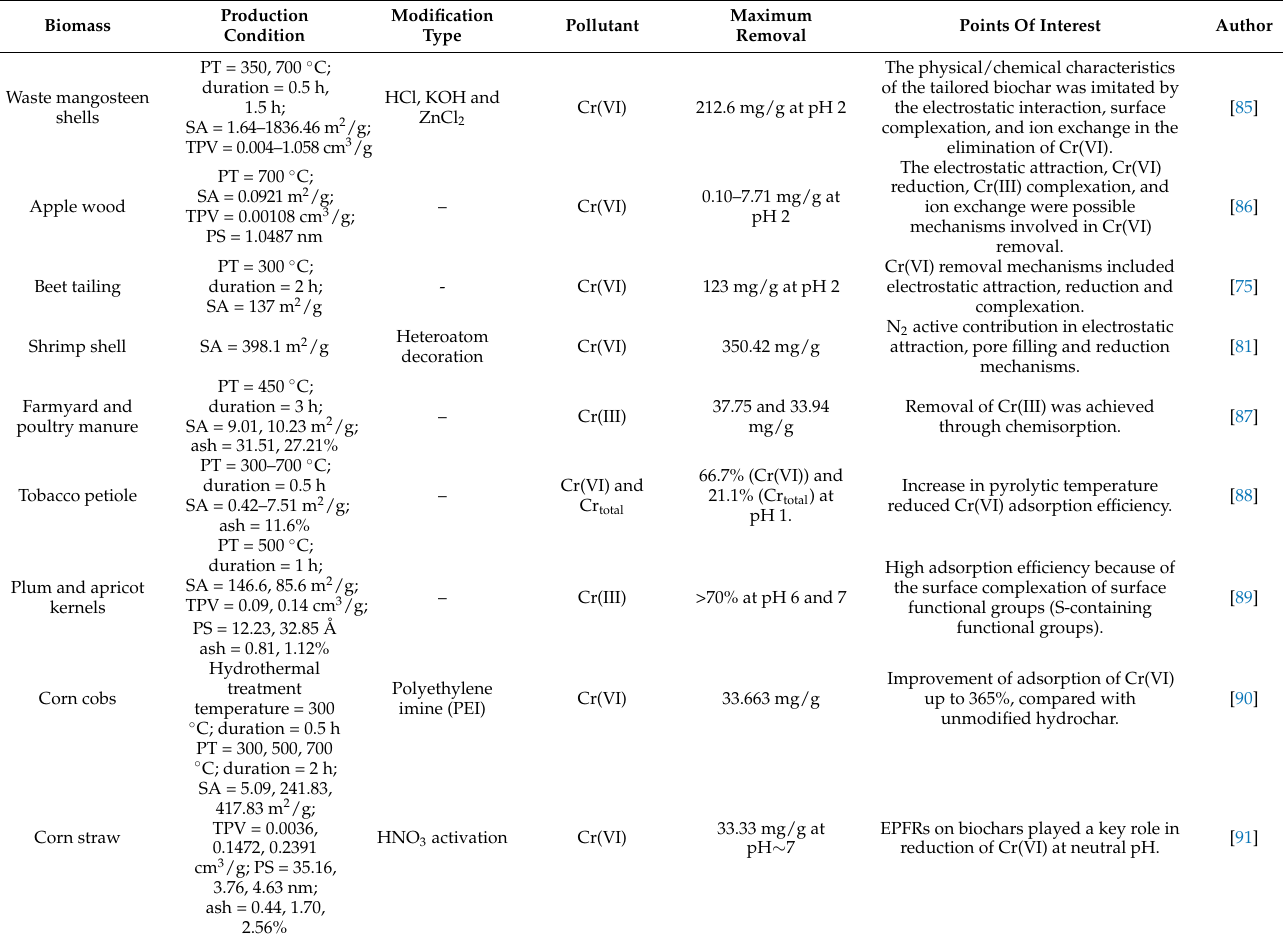
Table 6. Biochars by different types of biomasses and their characteristics (PT: pyrolysis temperature; PS: pore size; SA: surface area; TPV: total pore